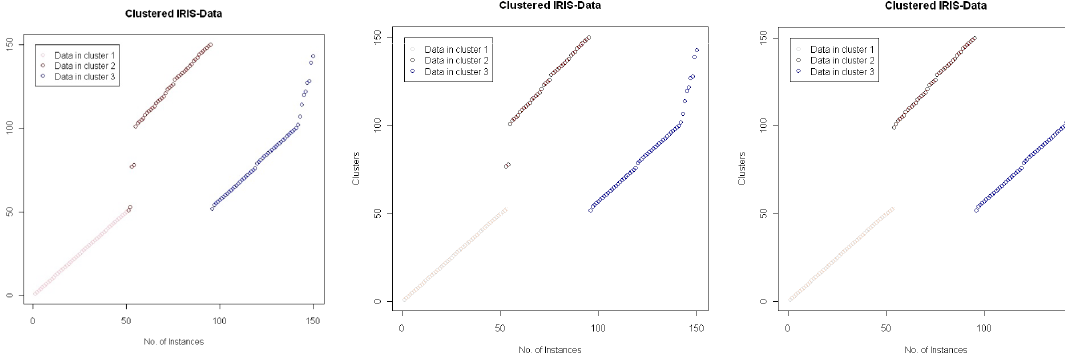
Fig. 20. IRIS Dataset: (i) Result by KFCM (ii) Result by KEFCM wd (iii) Result by KFCM nt .